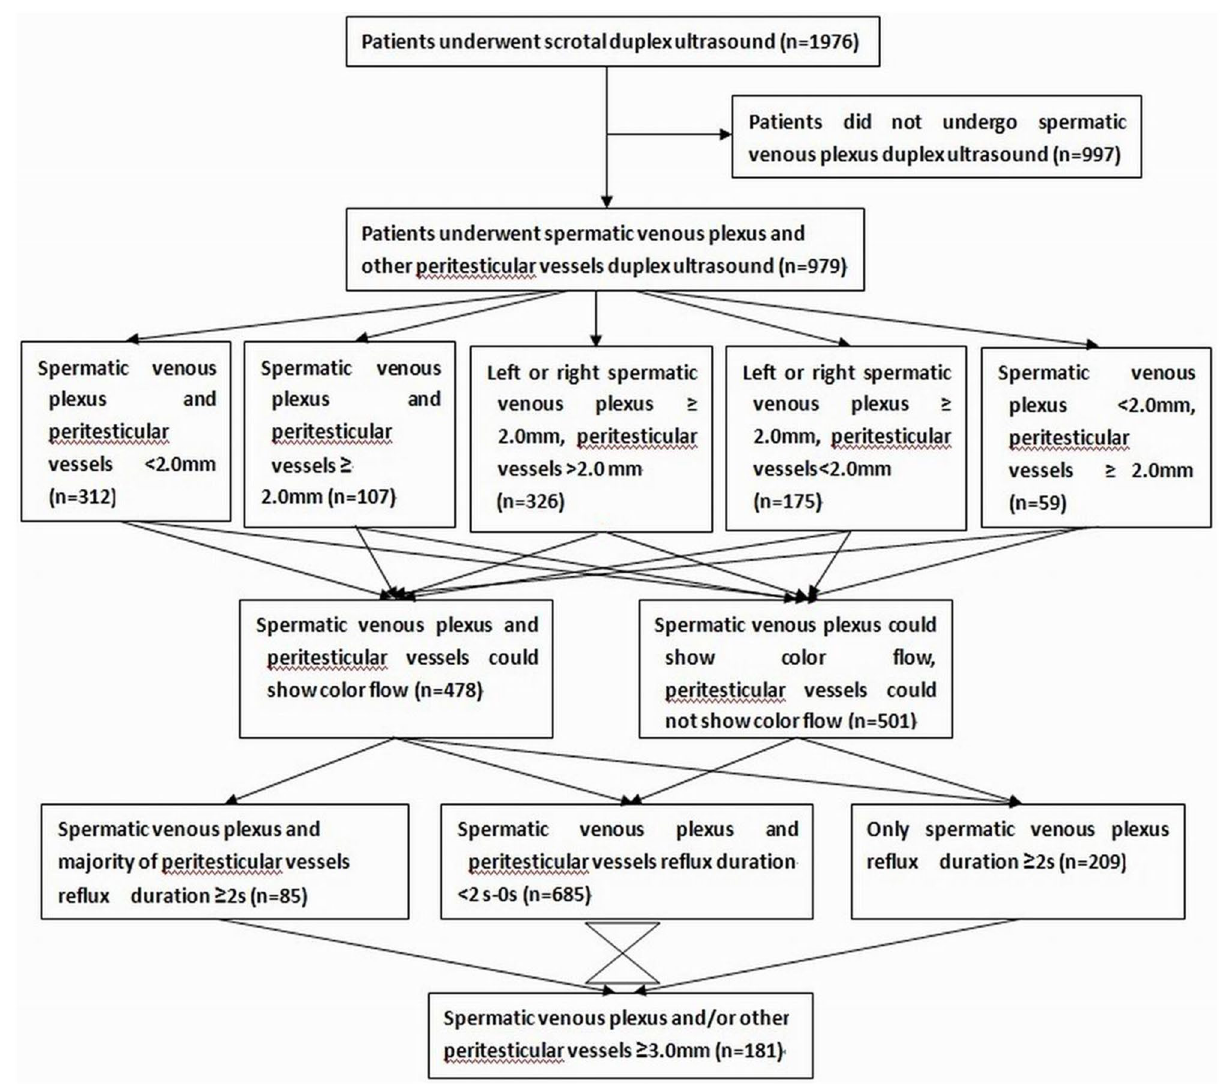
Figure 1. Flowchart of sample selection and duplex ultrasound